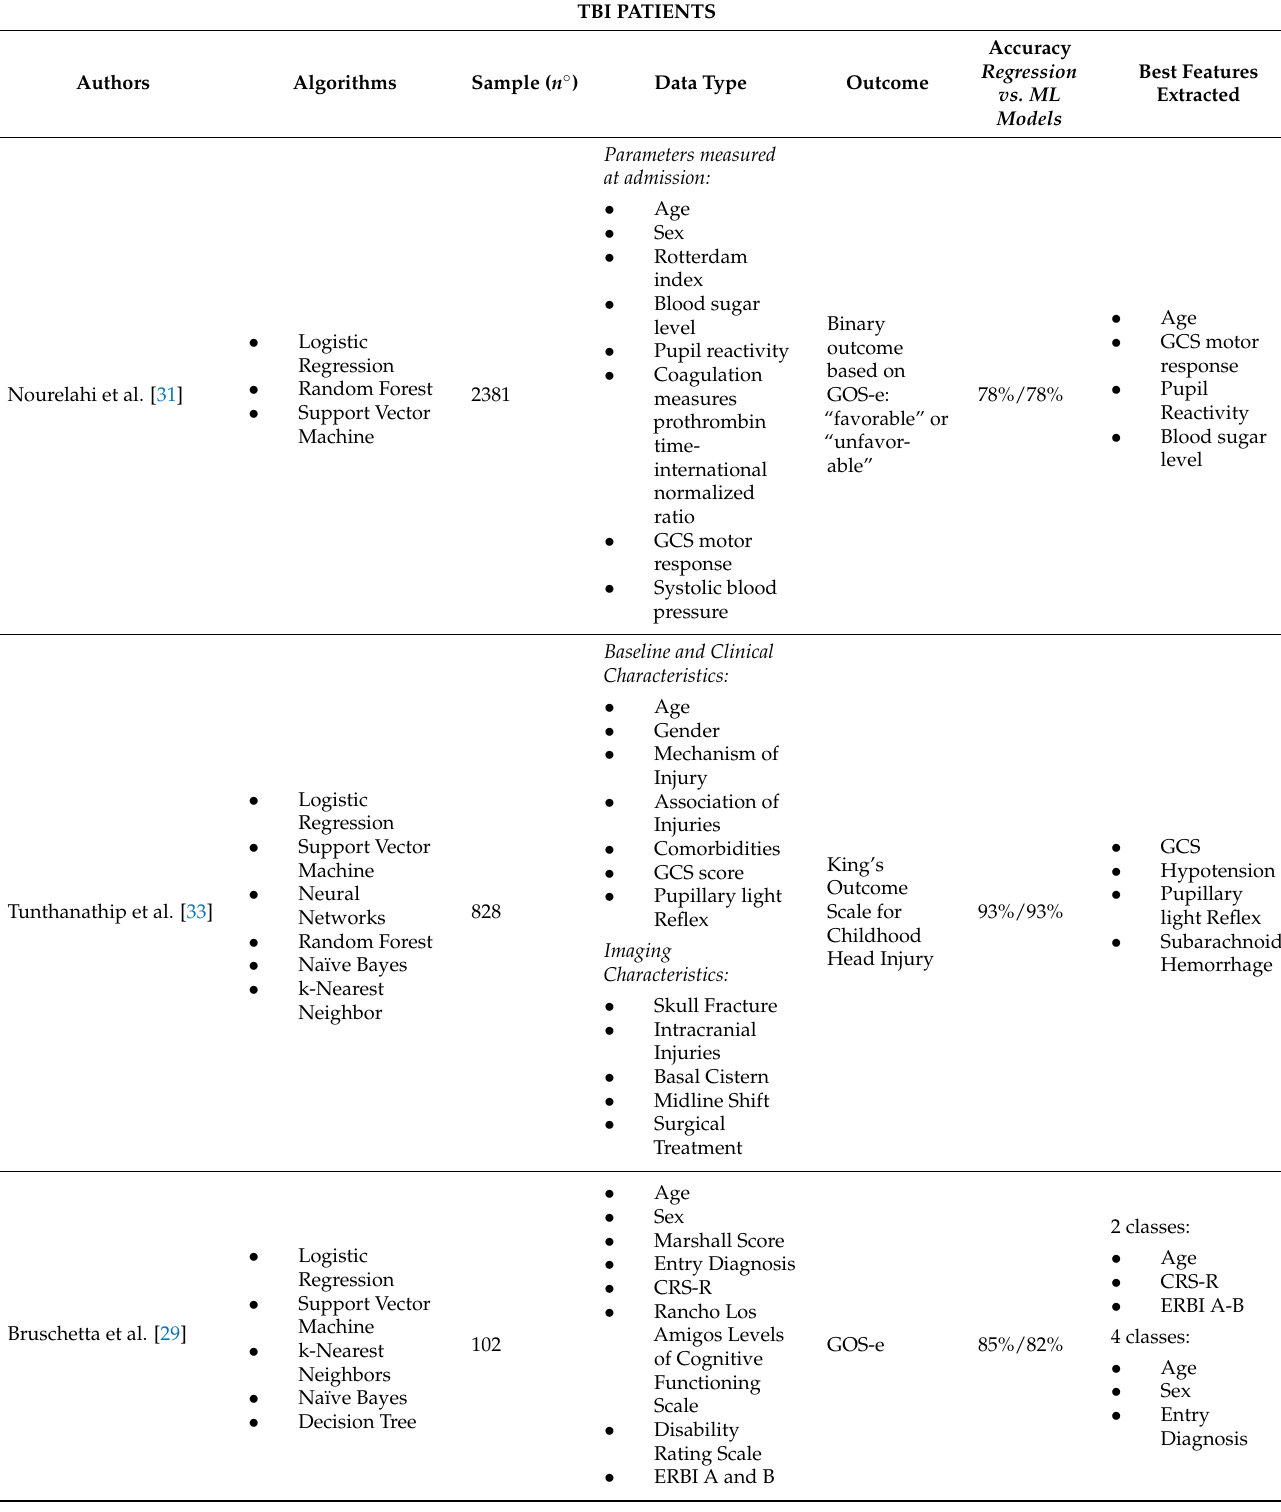
Table 2. Comparison between Machine Learning and linear regression approaches in traumatic brain injury patients to predict outcome at